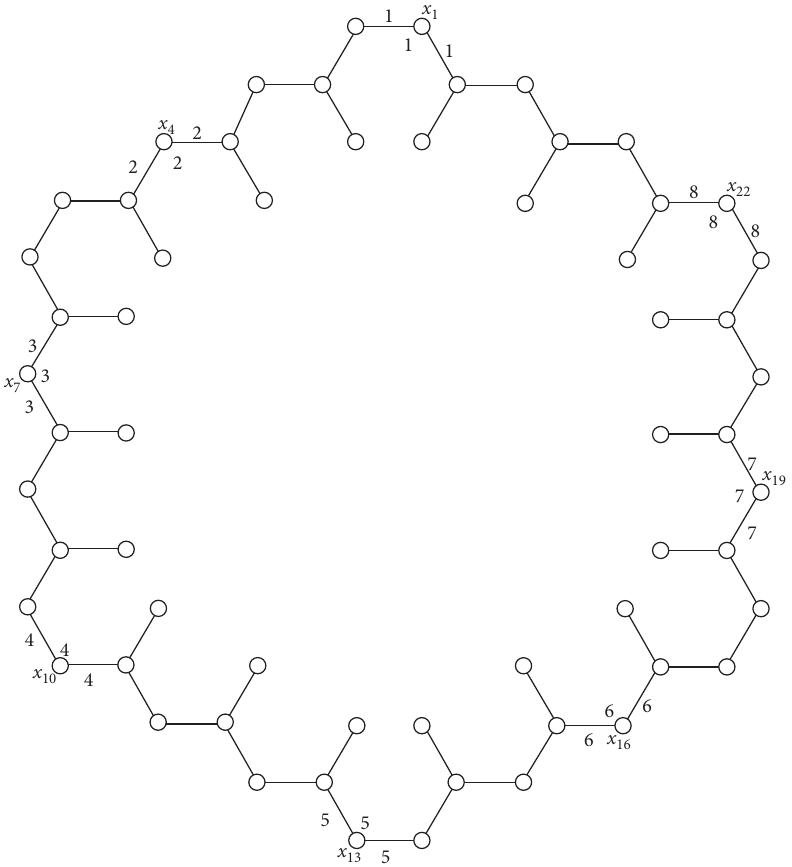
Figure 6: The labels of some vertices and edges of L